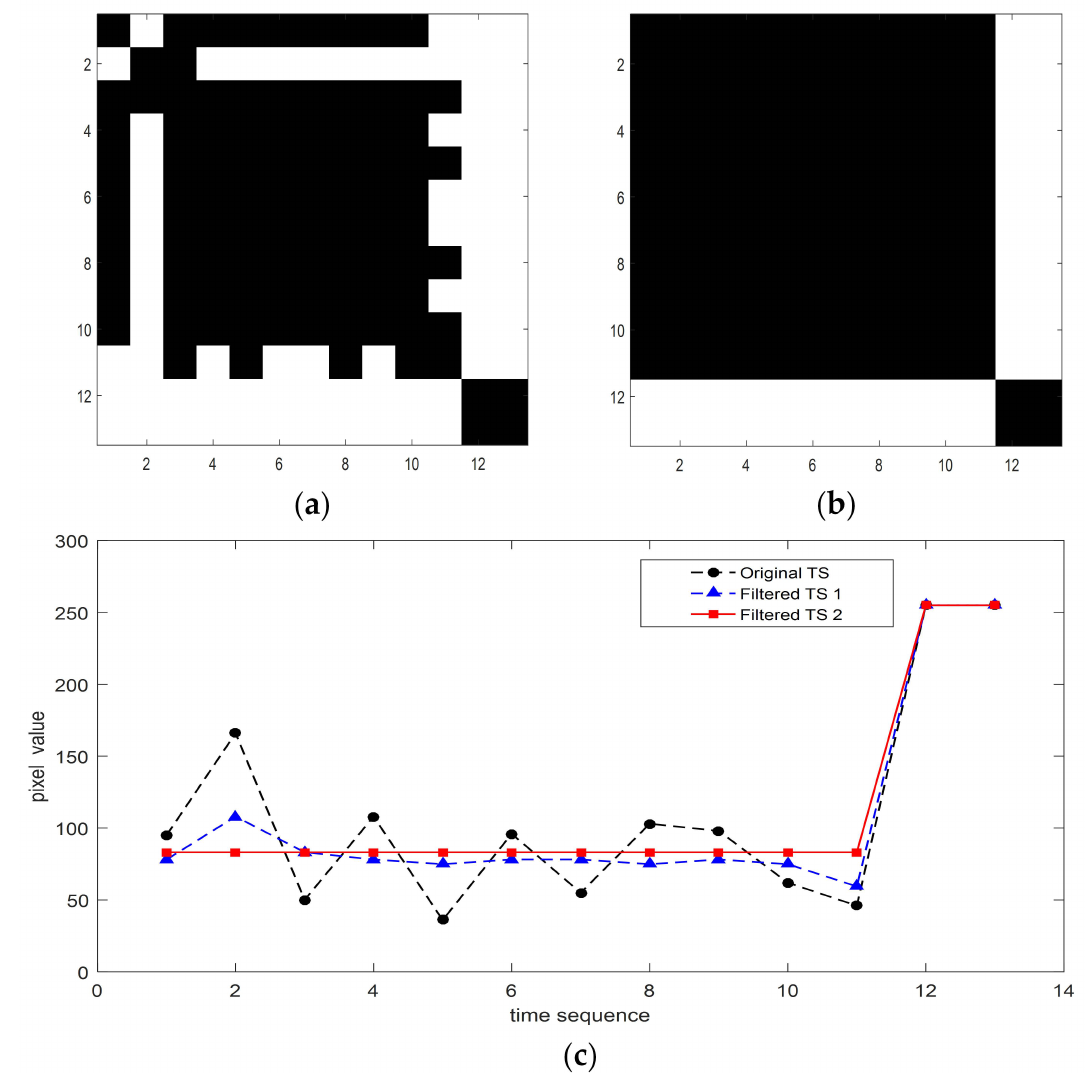
Figure 13. The similarity measurement matrix from the two-step strategy of Dataset 1: ( a ) Step 1; ( b ) Step 2; ( c ) filtering results of a pixel within the changeable building